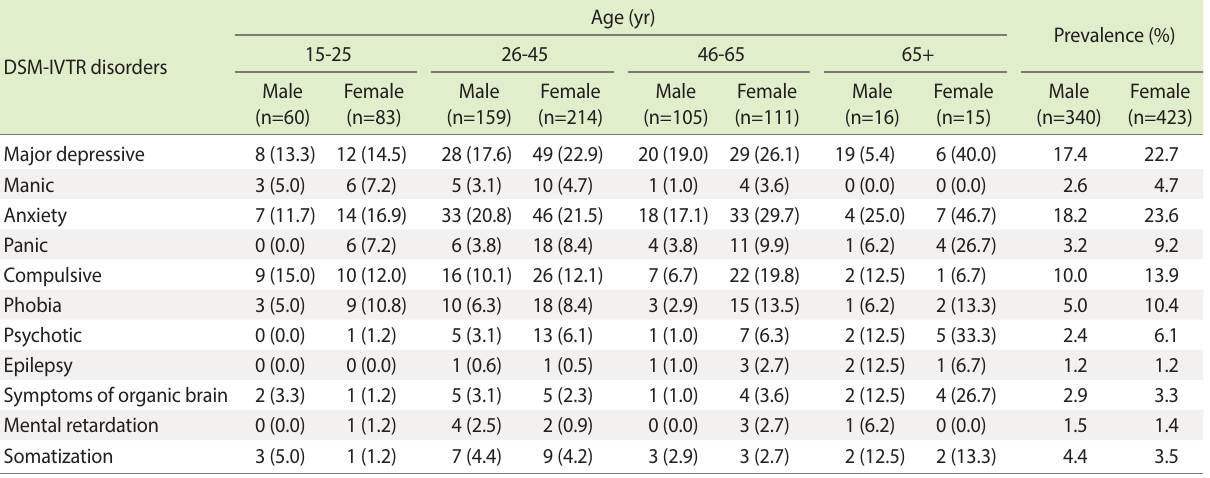
Table 2. Sex- and age-specific rates for DSM-IVTR mental disorders in both